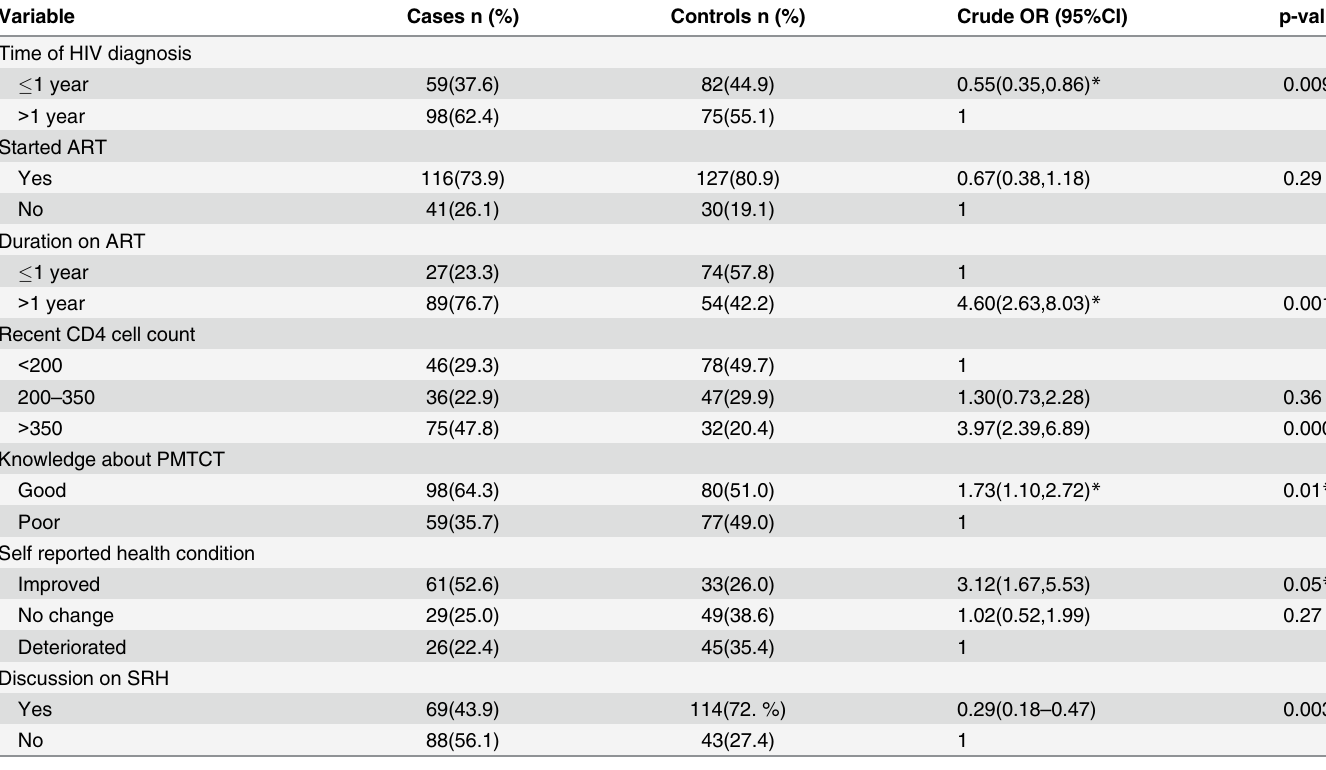
Table 3. HIV/ART related characteristics of cases and controls, Afar, Ethiopia,